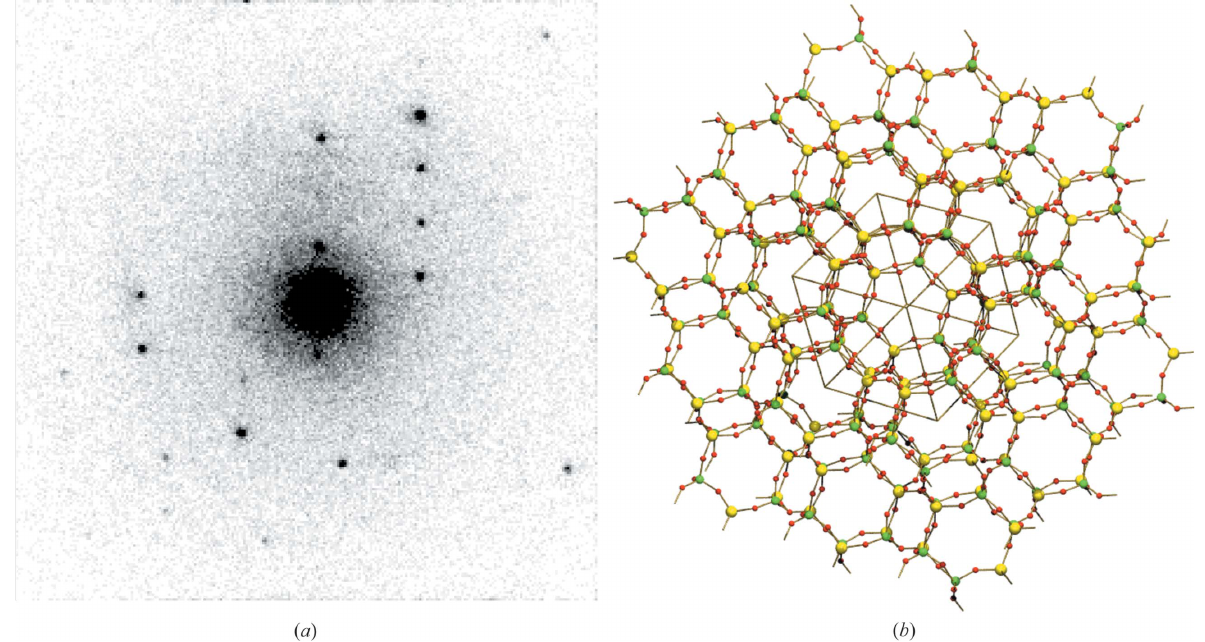
Figure 8 ( a ) A sample electron diffraction pattern for SAPO-34. ( b ) The structure of the SAPO-34 framework with T sites (P and Al, shown as green and yellow spheres, respectively) and oxygen atoms (shown as small red